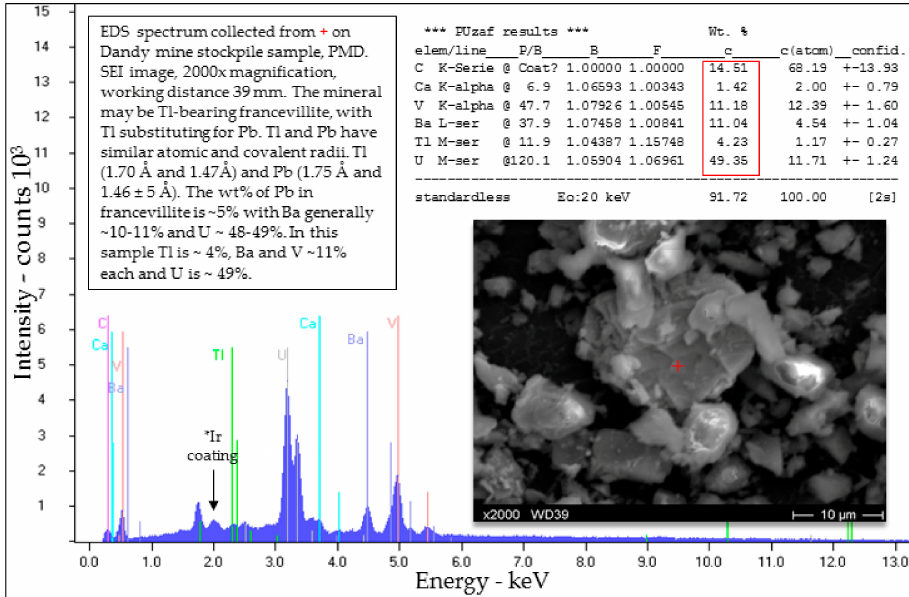
Figure A5. EDS spectrum for Tl-bearing uranyl vanadate from a sample collected from a stockpile area near the Dandy mine in the PMD. The weight percent of the elements are similar to francevillite which has an empirical formula Ba 0.75 Pb 0.25 (UO 2 ) 2 V 5+ 2 O 8 · 3(H 2 O) with weight percentage for the elements U (48.64%) V (10.41%) Ba (10.52%) Pb (5.29%) [114]. The sample may be a Tl-francevillite with Tl substituting for Pb. Sample was coated with Ir. The Ir peak is denoted by the *Ir and arrow. Ir coating was subtracted out before the normalization was performed by the program utilized by the